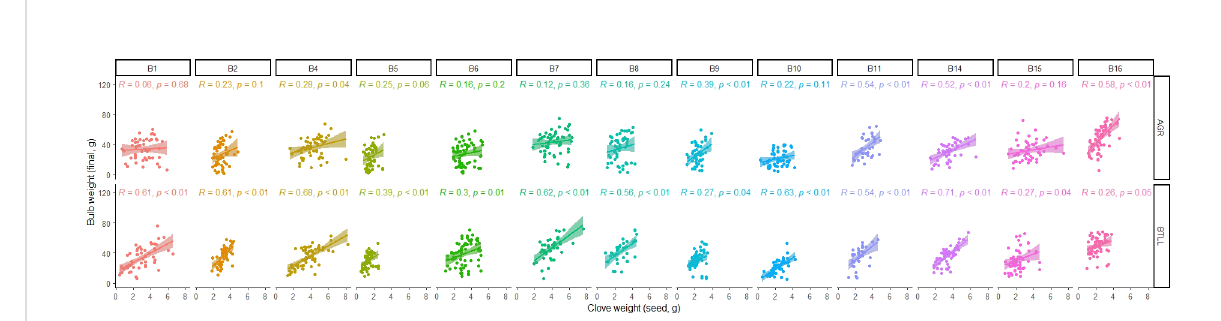
FIGURE 7 Correlation analysis between the weight of the sowing cloves and their corresponding bulbs weight at harvest of 13 Belltall accessions grown in Agropolis (AGR) and Belltall (BTLL).